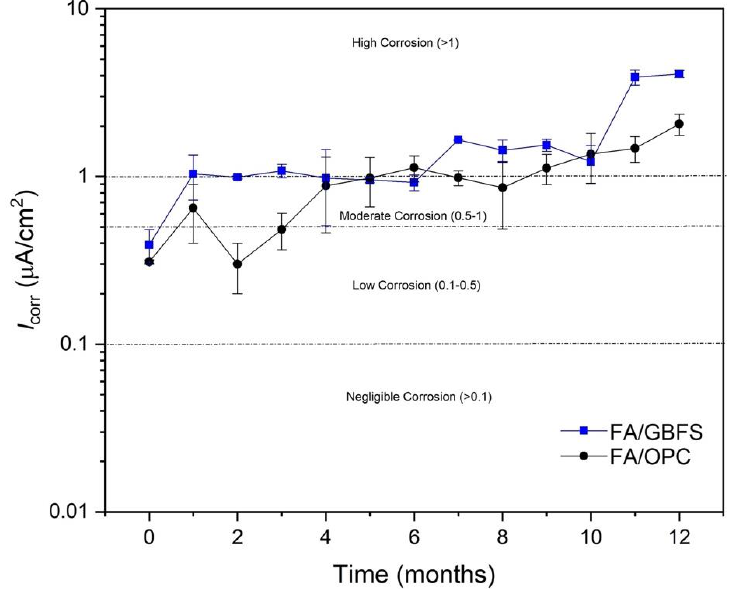
Figure 11. Current density (I corr ) of specimens exposed to 3.5%